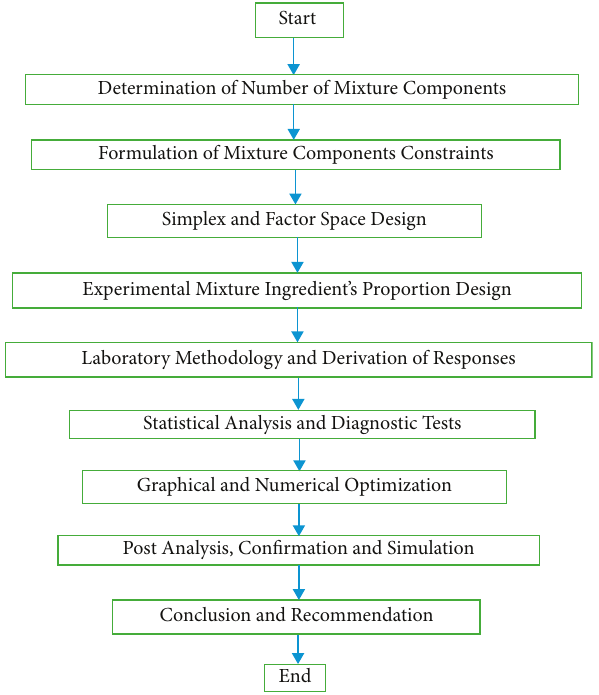
Figure 1: Program flowchart (source: Aju et al. [43]). Table 1: Design constraints.